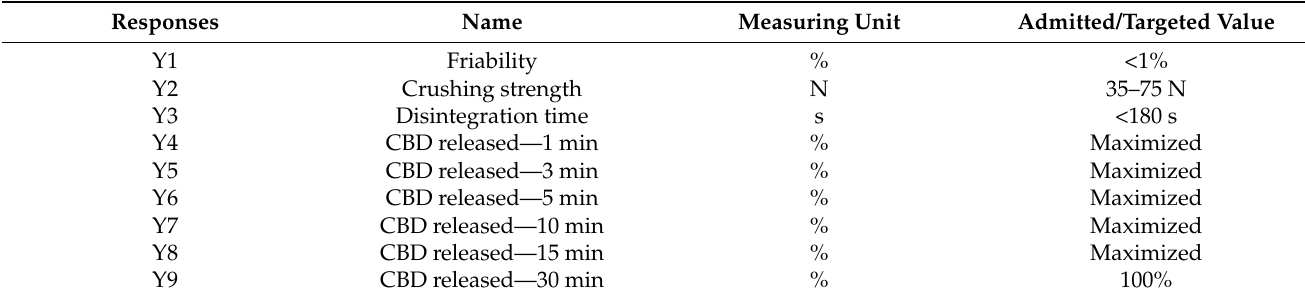
Table 3. The evaluated answers (dependent